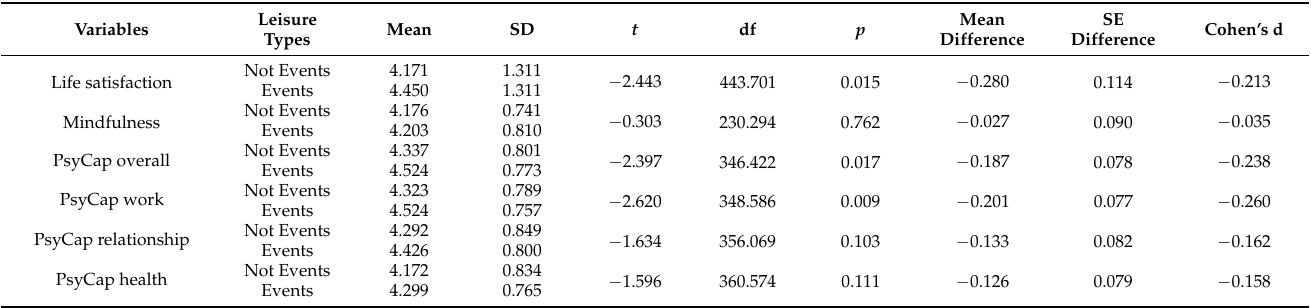
Table 9. Comparison (Welch’s t -test) of life satisfaction, mindfulness, and psychological capital in groups of respondents who prefer and do not prefer participation in events.